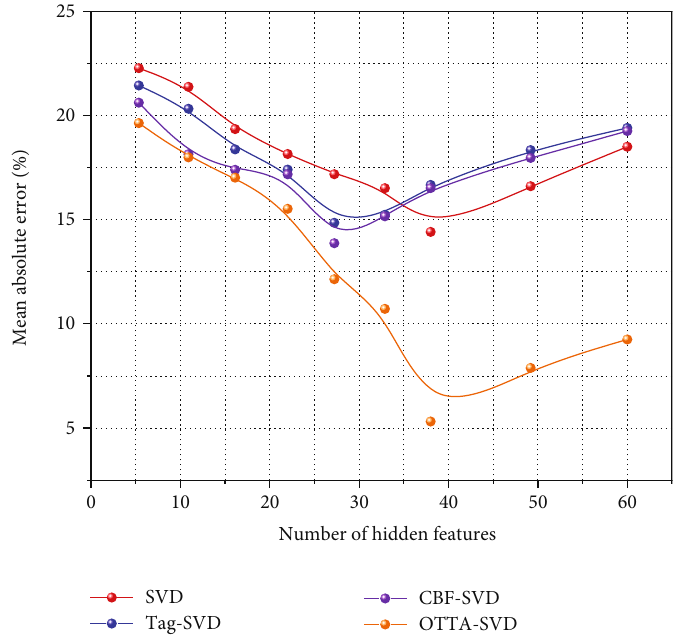
Figure 11: In fl uence of the number of latent features F on MAE.